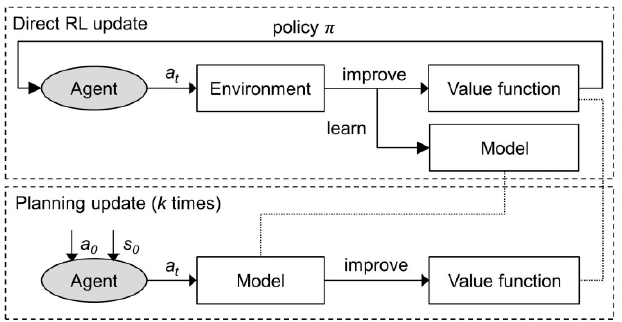
Figure 12. The general Dyna architecture. In the diagram Direct RL update and Planning update refer to the process of improving the policy and the value function via real and simulated experience, respectively. a 0 and s 0 represent the initial action and state used to initialize the planning phase.